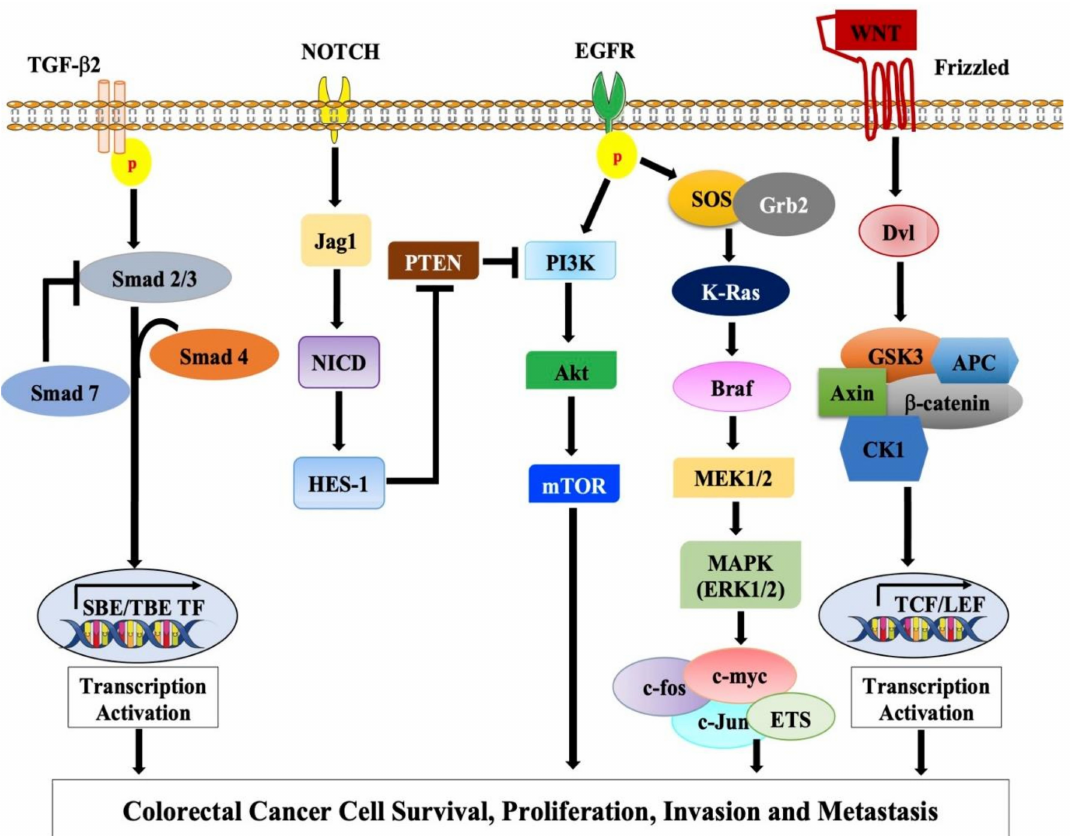
Figure 2. Schematic representation of the molecular pathways involved in CRC